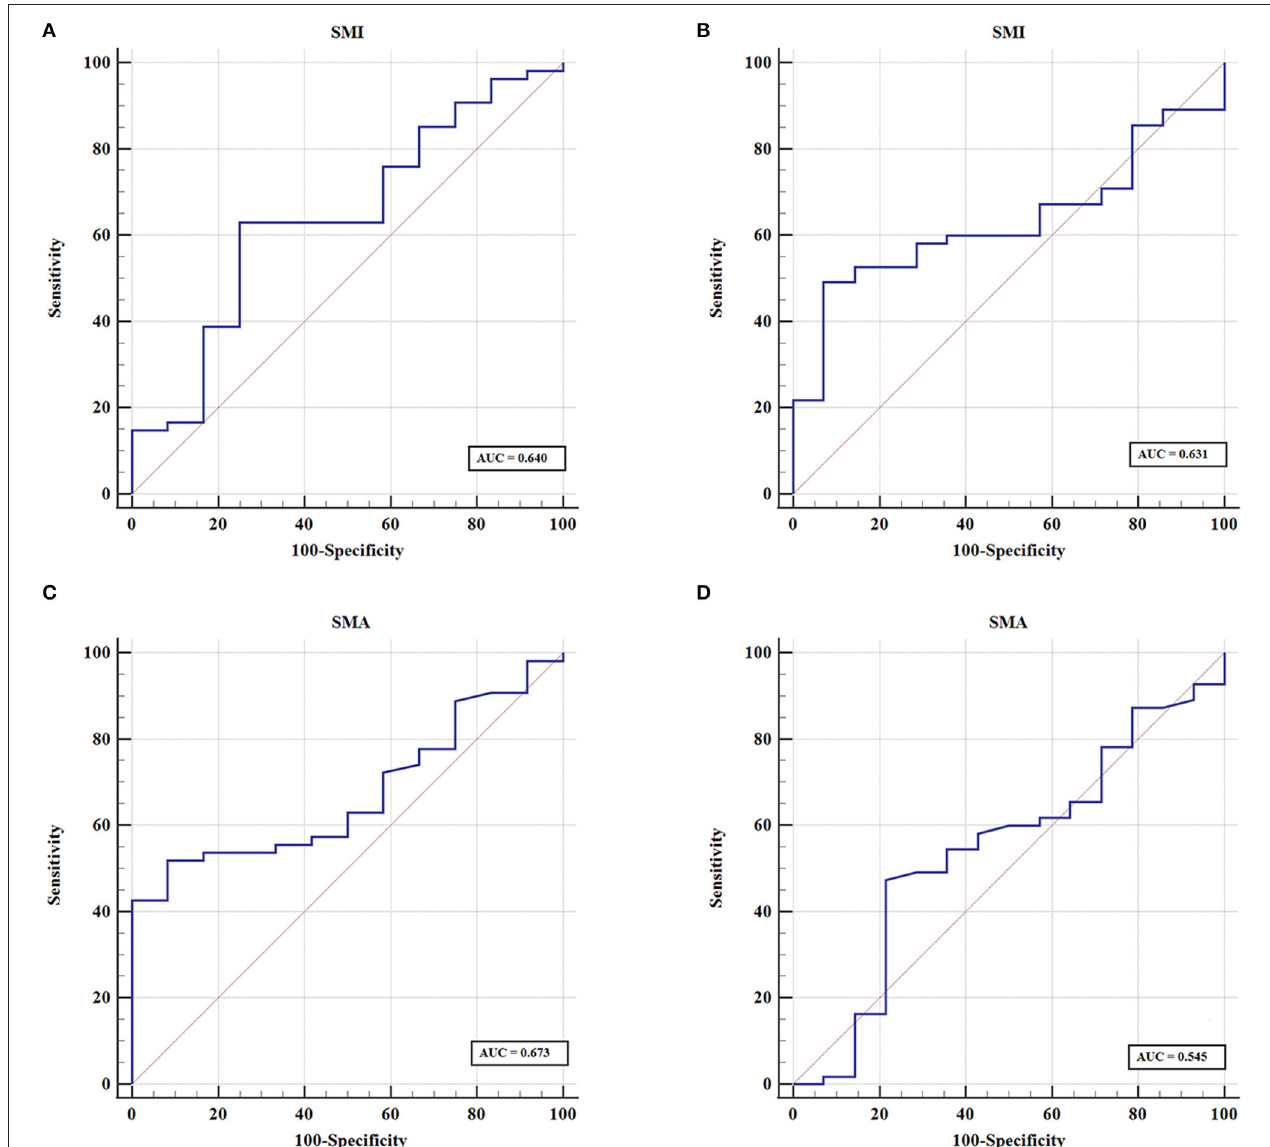
FIGURE 4 | Sex-specific cutoff values established for skeletal muscle index (SMI) and skeletal muscle attenuation (SMA) using ROC curves. (A) The optimal cutoff of SMI value in men. (B) The optimal cutoff of SMI value in women. (C) The cutoff value for SMA in men. (D) The cutoff value for SMA in women.